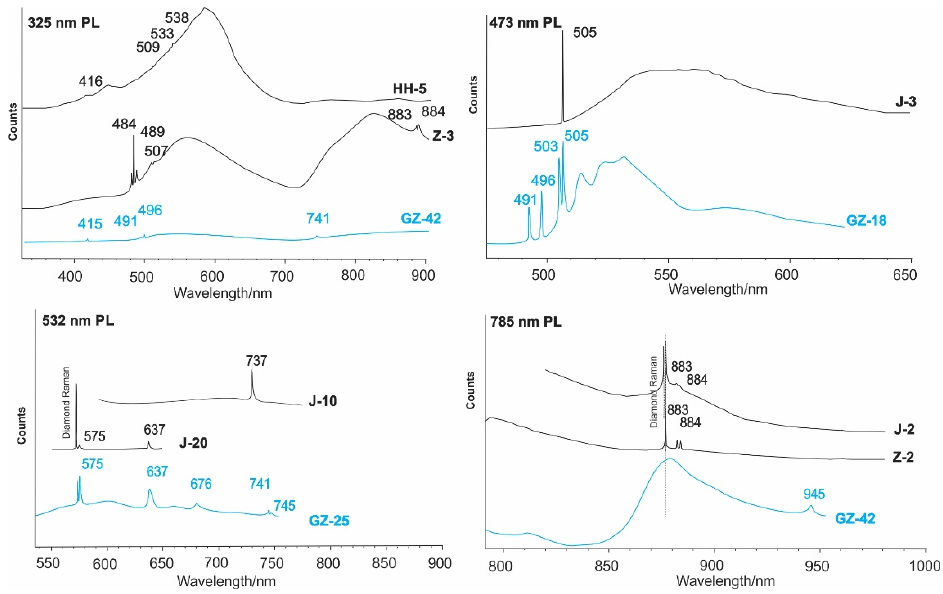
Figure 5. PL Spectroscopy of typical samples (GZ samples in blue color, HPHT samples in black color).